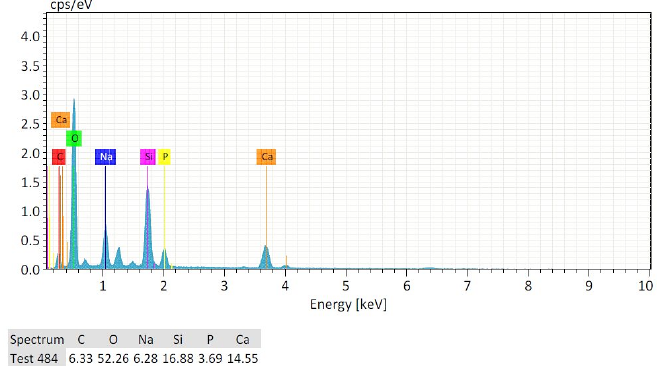
Figure 13. EDS curve of Bioglass after immersion in SBF